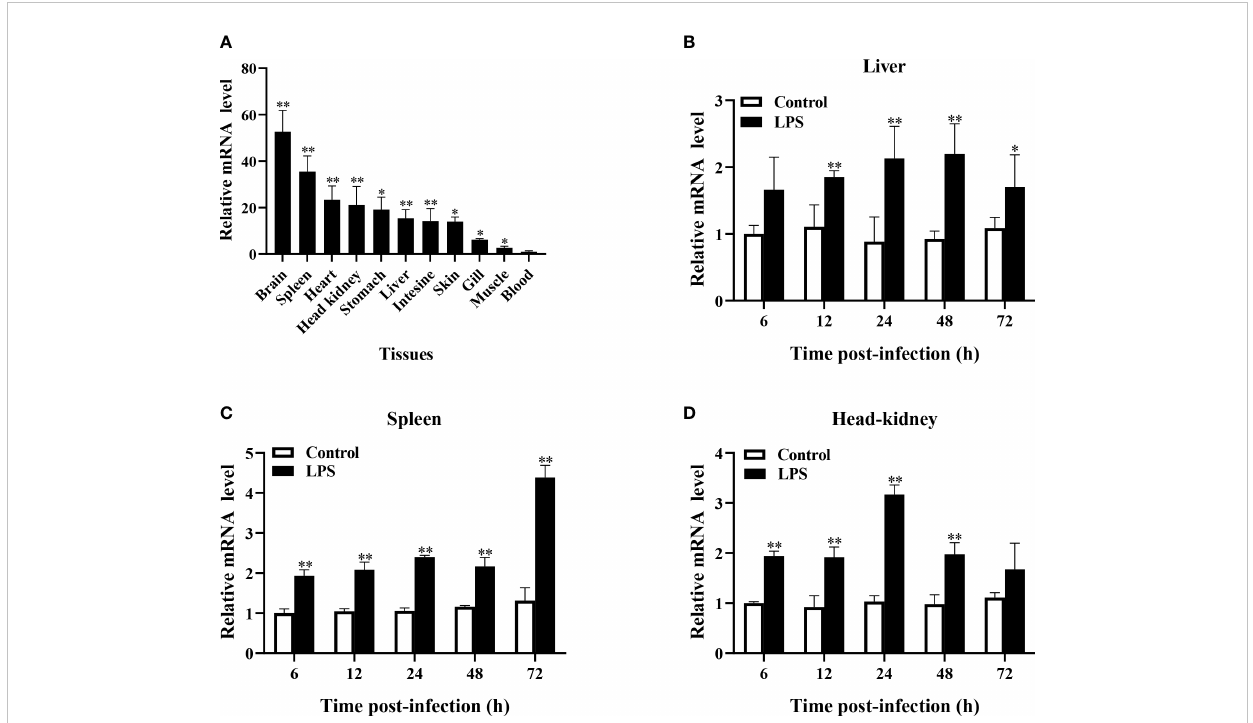
FIGURE 2 Expression pro fi les of TroBcl2 mRNA in healthy Trachinotus ovatus and after LPS stimulation. The distribution of TroBcl2 mRNA in various tissues of healthy T. ovatus was detected by qRT-PCR (A) . The relative mRNA expression level of TroBcl2 was calculated, while the lowest mRNA transcript level in the blood was set to 1. The mRNA expression pro fi les of TroBcl2 were investigated in the liver (B) , spleen (C) , and head kidney (D) at various time points post LPS challenge were investigated by qRT-PCR. The internal reference gene in both experiments was B2M . Vertical bars represent means ± SD. ** P < 0.01, * P <